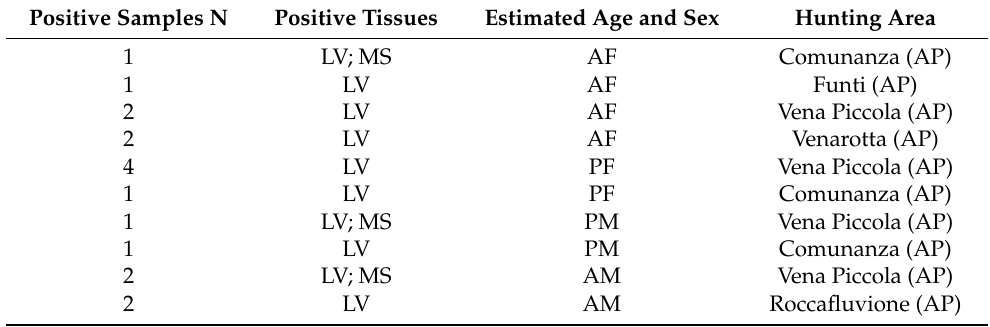
Table 3. Positive subjects reported basing on tissue types, age, sex and hunting geographical area. Positive Samples N Positive Tissues Estimated Age and Sex Hunting Area 1 LV; MS AF Comunanza (AP)